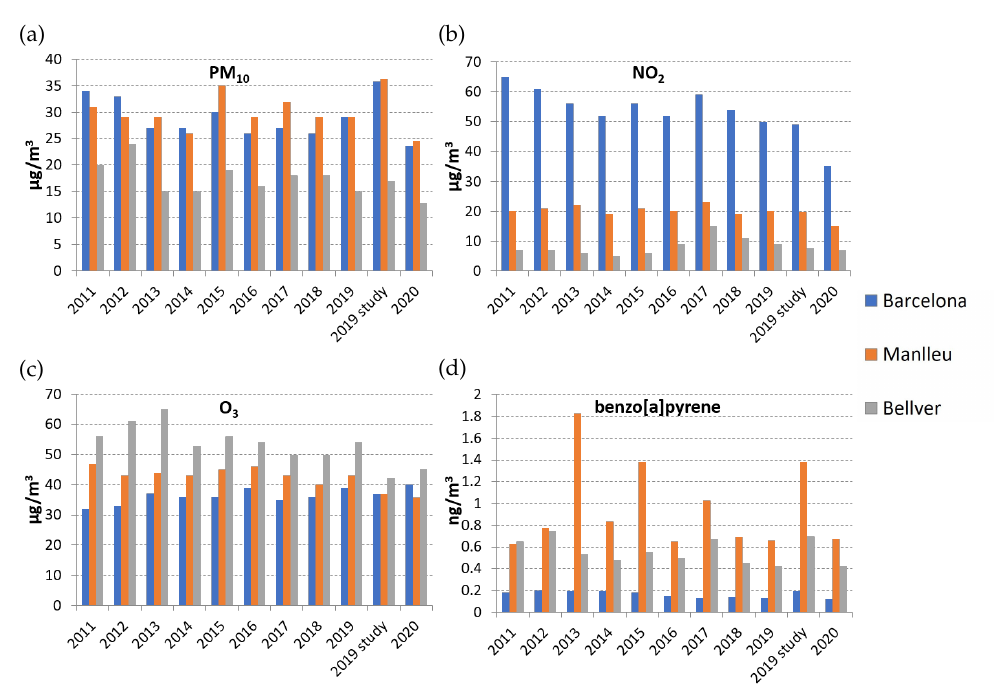
Figure 2. Mean concentrations of ( a ) PM 10 , ( b ) NO 2 , ( c ) O 3 , and ( d ) benzo[a]pyrene in the air quality monitoring stations of Barcelona (Eixample), Manlleu, and Bellver de Cerdanya run by the regional authorities. The mean concentrations of the fifteen samples that were studied for source apportionment are indicated by “2019